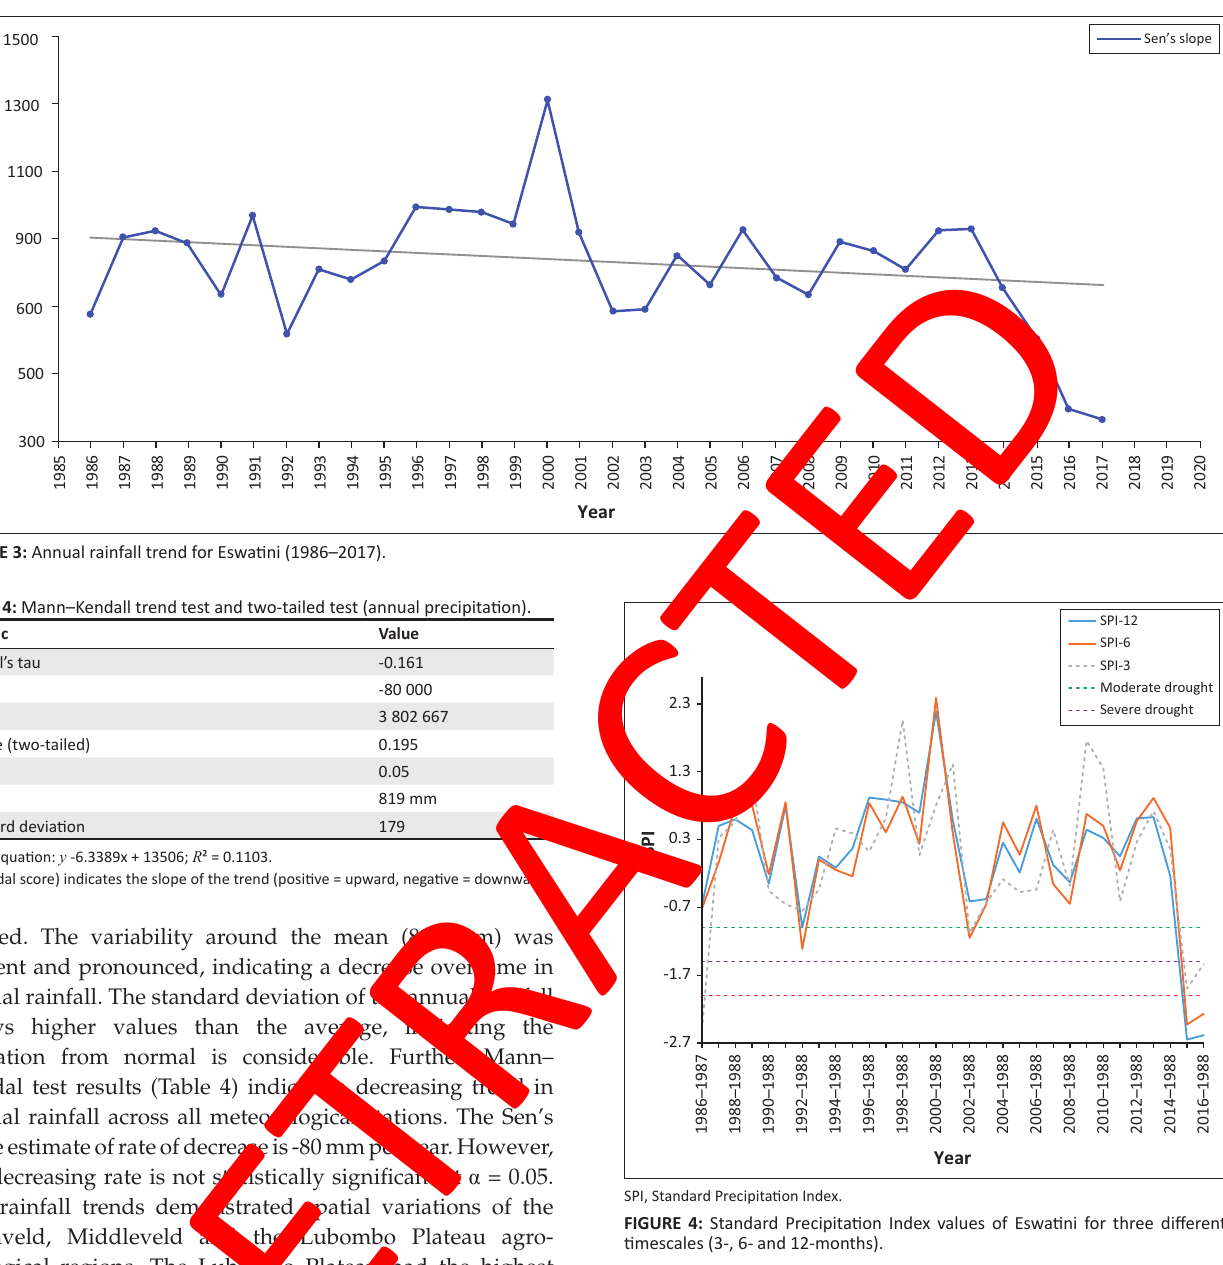
FIGURE 4: Standard Precipitation Index values of Eswatini for three different timescales (3-, 6- and